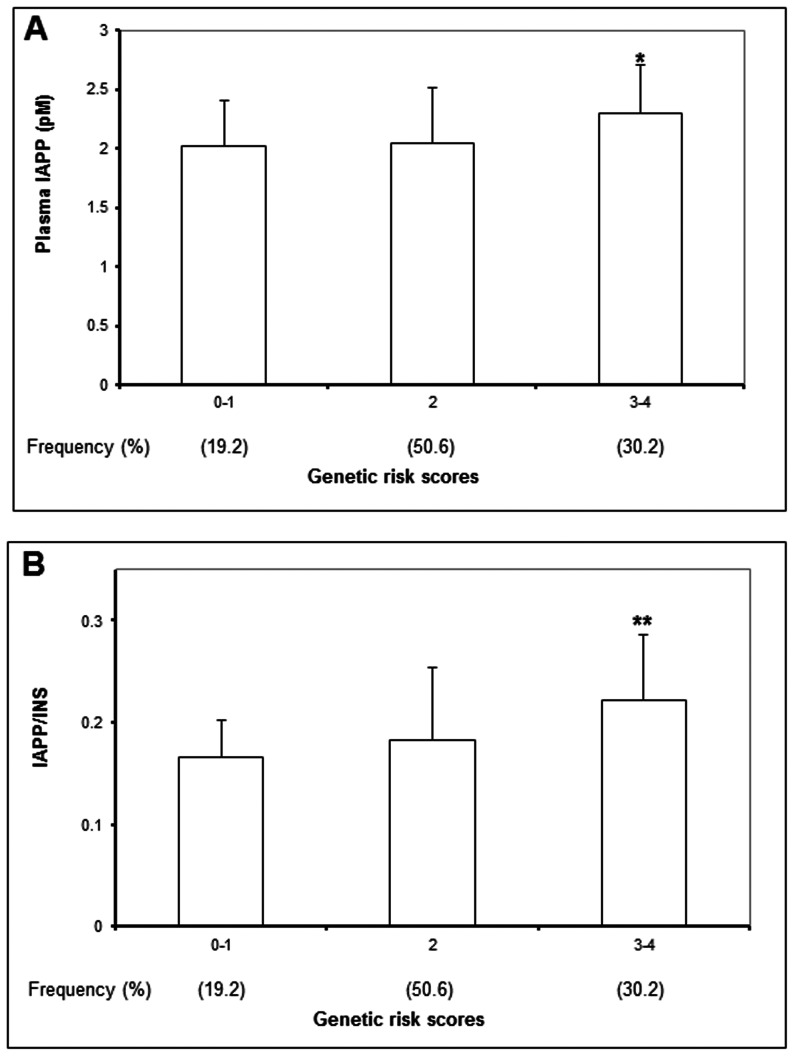
Plasma IAPP (A) and molar ratio of IAPP to insulin (IAPP/INS) (B) in 85 unrelated non-diabetic controls selected from a family-based cohort categorized by genetic risk scores (GRS) (1 risk allele of rs1583645 of CPE and rs6583813 of IDE each given 1 point).Plasma IAPP (*P = 0.008) and IAPP/INS ratio (**P = 0.006) increased with increasing GRS.